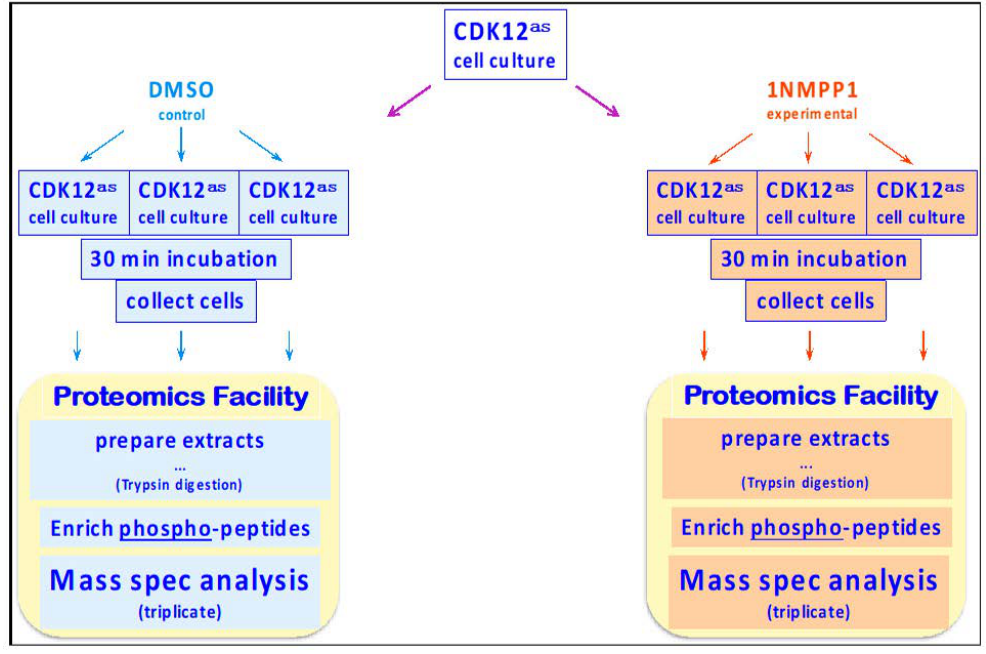
Figure 1. Diagrammatic overview of experimental